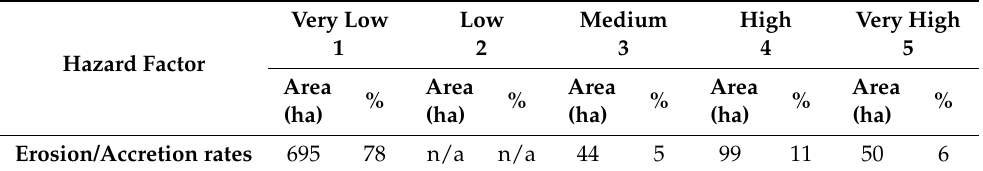
Table 23. Areas and percentages of the study area classified as each class of the erosion/accretion rates hazard factor.